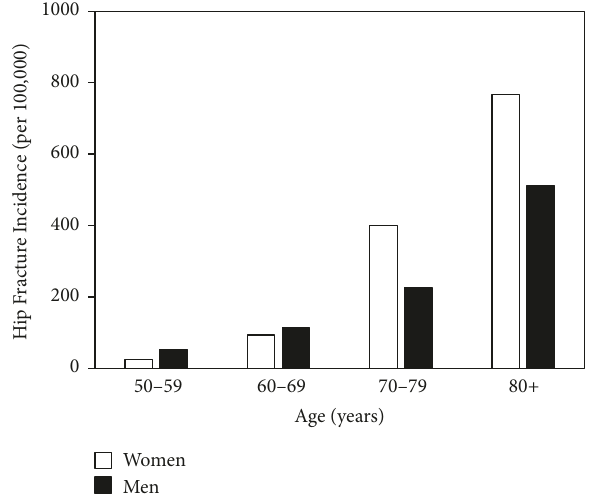
Figure 1: Hip fracture incidence per 100,000 in men and women in Vinnitsa city, across the age bands shown, for data collected across 1997–2002